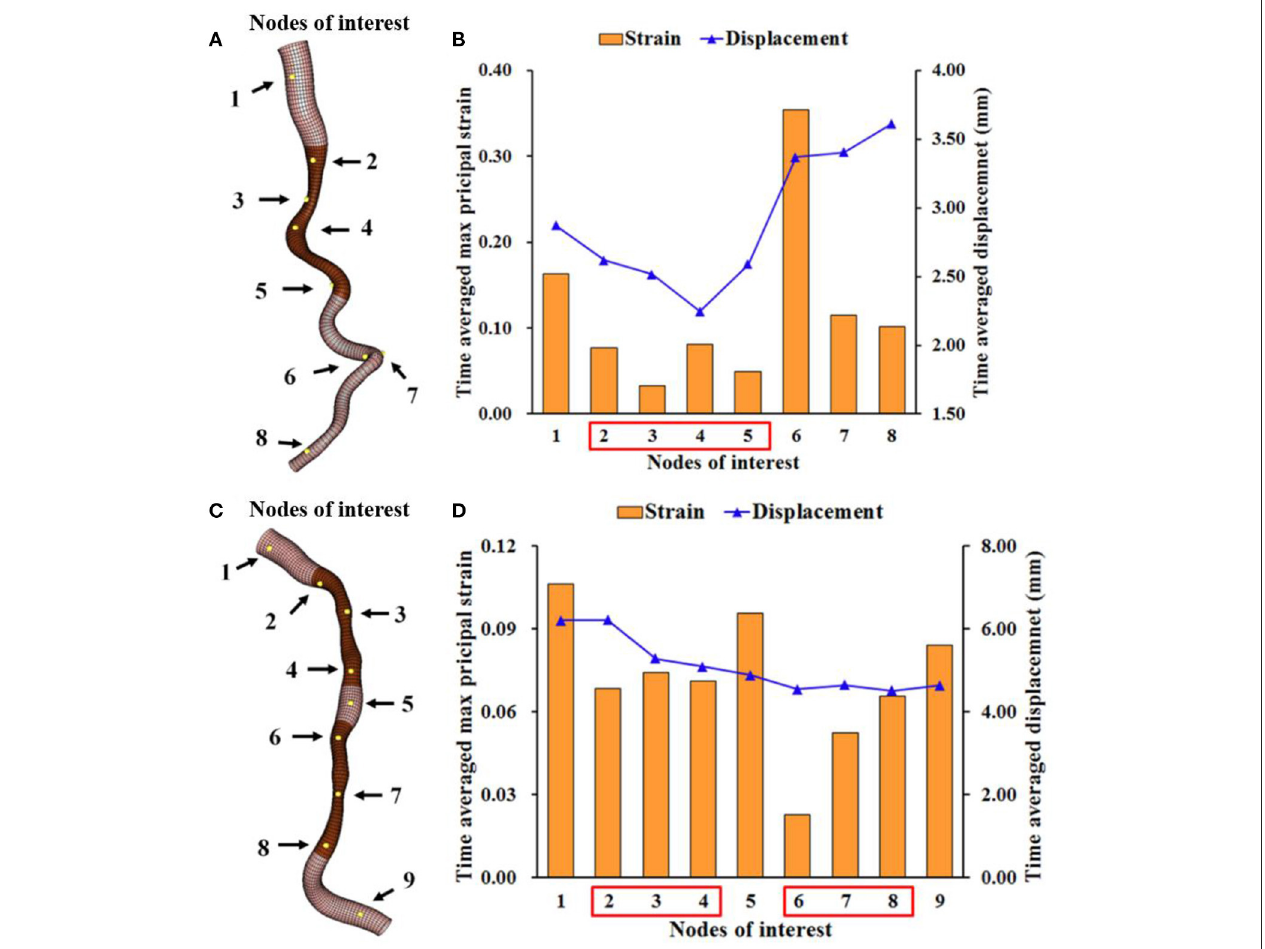
FIGURE 3 | Time-averaged maximum principal strain and displacement at several locations on the LAD and diagonal arteries. The time-averaged maximal principal strain and displacement at the numbered nodes of interest on the diagonal (A,B) and LAD (C,D) with stenostic segments (dark brown). These nodes at the stenotic segments have lower strain than those at the normal